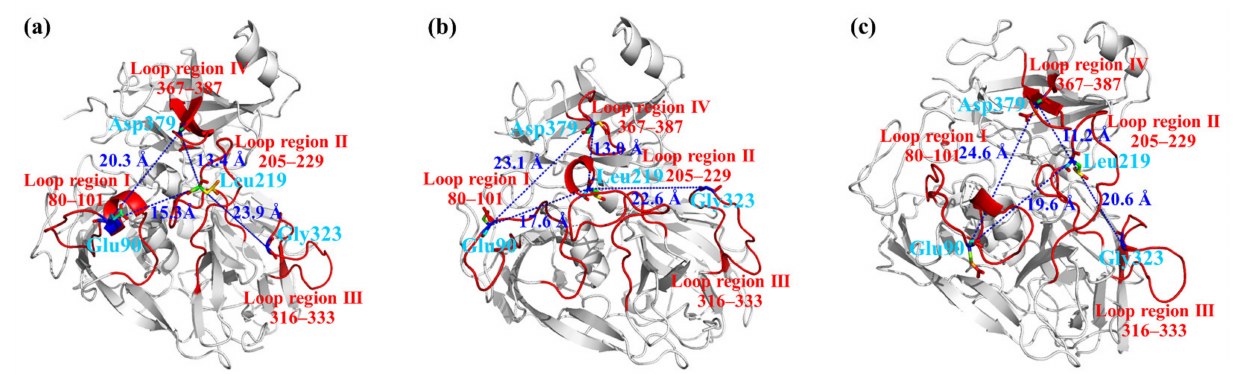
Figure 4. The effect of temperature on the rLAC conformation at the end of MD simulations. ( a ) 325 K; ( b ) 355 K; ( c ) 365 K. The distance among the representative amino acid residues in each loop (Glu90 in loop region I; Leu219 in loop region II; Gly323 in loop region III; Asp379 in loop region (IV) were marked with a green dashed line and specific values.